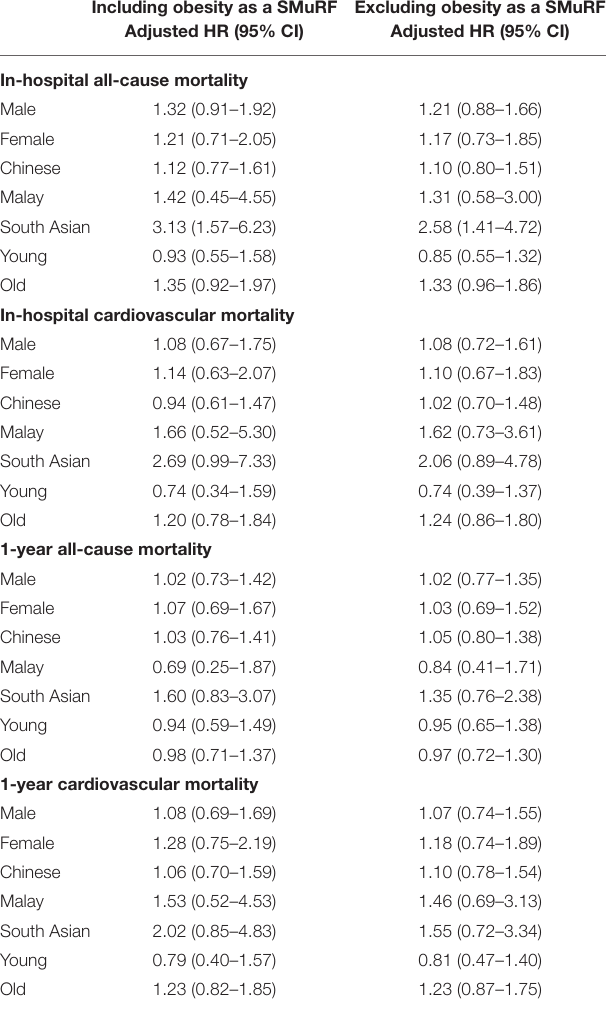
TABLE 4 | Risk of death among SMuRF-less AMI patients compared to those with at least one SMuRF (reference) within subgroups. Including obesity as a SMuRF Excluding obesity as a SMuRF Adjusted HR (95% CI) Adjusted HR (95%